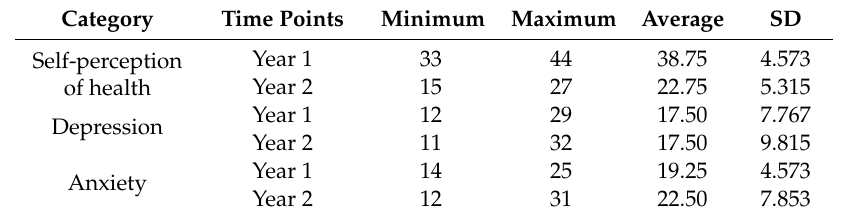
Table 2. The emotional state of mothers carrying microcephalic children in two-time points.